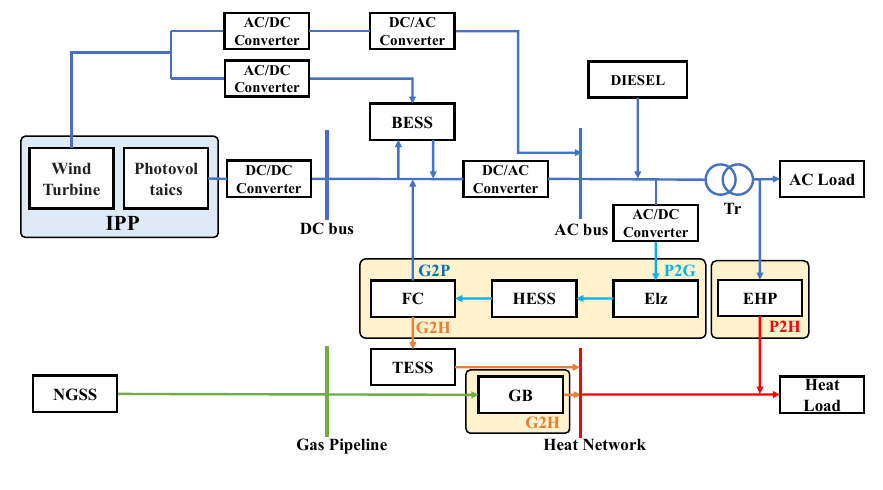
Figure 1. Schematic diagram of IES.